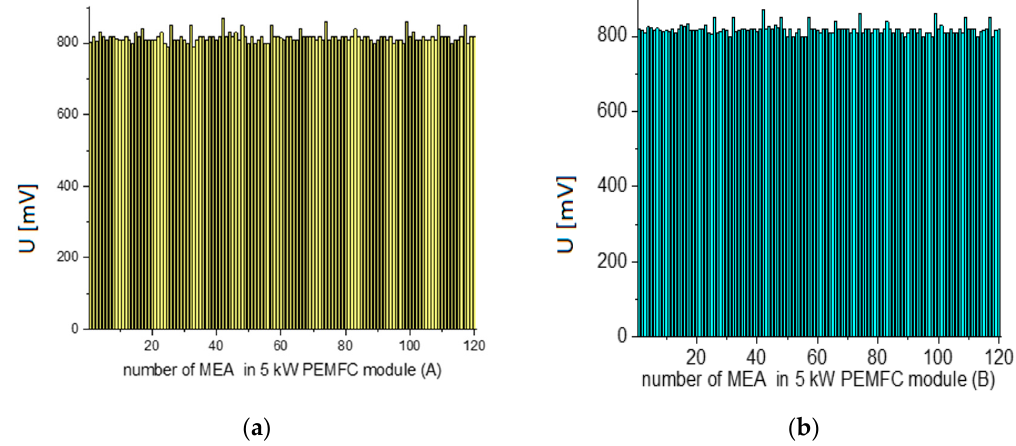
Figure 7. ( a ) The voltage U distribution recorded for single MEA placed in 5 kW module (A). ( b ) The voltage U distribution recorded for single MEA placed in 5 kW module (B).